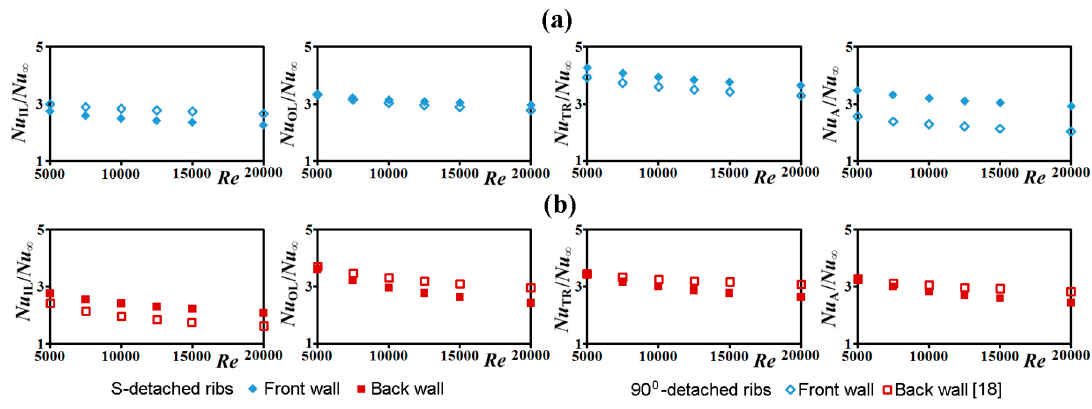
Figure 3. Variations of Nu IL / Nu ∞ , Nu TR / Nu ∞ , Nu OL / Nu ∞ , and Nu A / Nu ∞ against Reynolds number for ( a ) front ( b ) back endwalls of twin-pass parallelogram channels with detached S-ribs and 90° ribs [18].